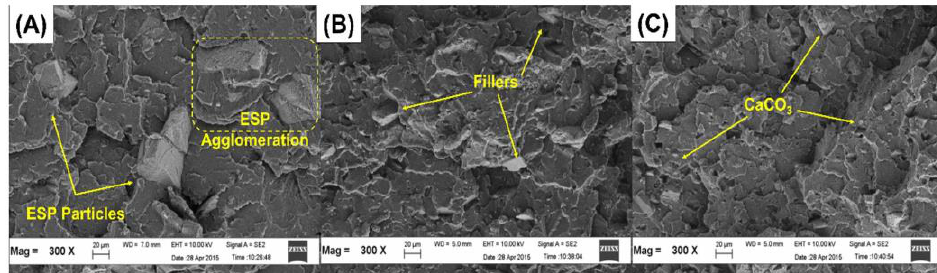
Figure 41. Evidence of homogenous CaCO 3 dispersion in tensile fracture surfaces recycled PS/ESP/CaCO 3 at ( A ) 80/20/0 wt.%, ( B ) 82/10/10 wt.%, and ( C ) 80/0/20 wt.%, respectively. Reprinted with permission from ref. [114].